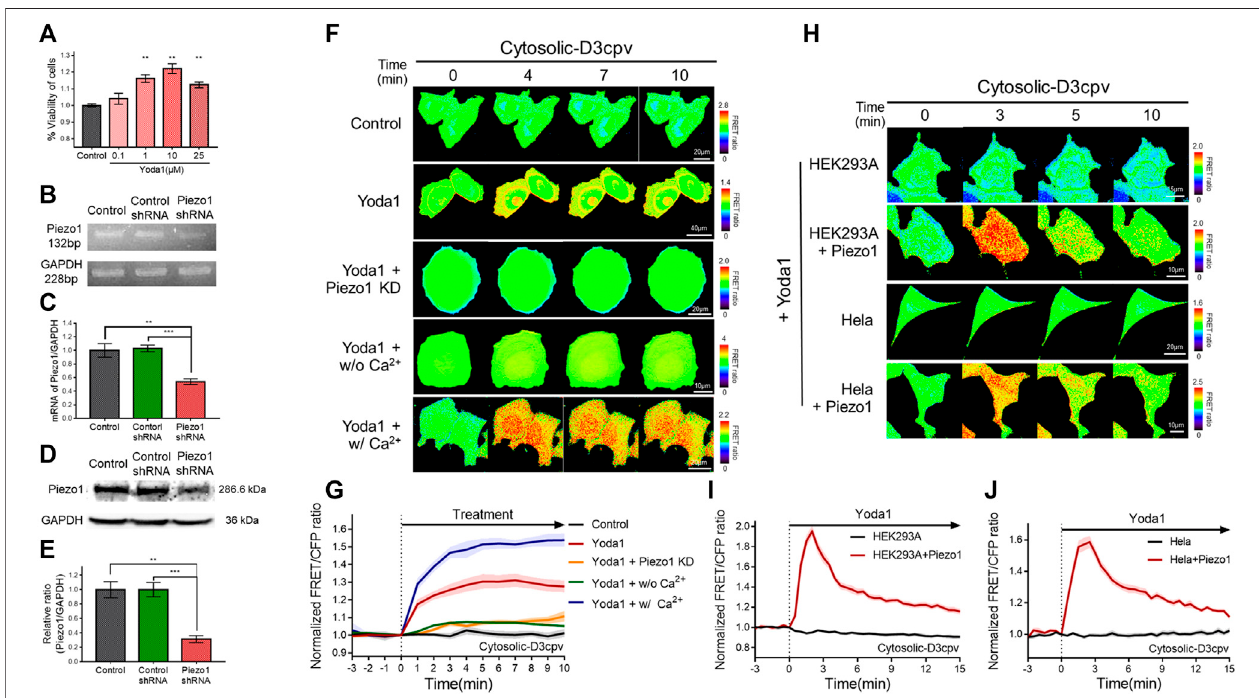
FIGURE 2 | Piezo1-mediated extracellular Ca 2+ in fl ux induced by Yoda1 in various cell lines. (A) Viability of MCF-7 cells exposed to control [0.2% (v/v) DMSO] and Yoda1 (0.1 – 25 μ M) for 24 h, measured using the WST-8 assay. The bar graphs describe mean values of cell viability with error bars indicating the standard error of the mean (S.E.M) ( n = 4, ** p < 0.01, student t -test). (B,D) Piezo1 expression in MCF-7 cells with or without control/Piezo1 shRNA as analysed by (B) RT-PCR and (D) westernblotting.GAPDHwasusedasaninternalcontrol. (C,E) Thebargraphsdescribethecumulativedensitometric analysisof (C) RT-PCRand (E) westernblot bands normalized to the GAPDH. Data are presented as the means ± S.E.M ( n = 4, ** p < 0.01 and *** p < 0.001, student t -test). (F,H) Time-lapse FRET images of the Cytosolic-D3cpvin (F) MCF-7cells, (H) HEK293AandHeLacellsintroducedwithorwithoutexogenousPiezo1.MCF-7cellswereexposedtocontrol[0.2%(v/v)DMSO] and Yoda1 (1 μ M) dissolved in CO 2 -independent culture medium (Yoda1 group), Ca 2+ -free medium (Yoda1 + w/o Ca 2+ group), and Ca 2+ medium (Yoda1 + w/Ca 2+ group), respectively. (F) Yoda1 + Piezo1 KD group and (H) HEK293A and HeLa cells were incubated in CO 2 -independent culture medium. The color scale bars represent the range ofthe FRET/CFP emission ratio determined using the biosensor. Hot and cold colors indicate high and lowCa 2+ concentration, respectively. (G,I,J) ThetimecoursesrepresenttheaverageofthenormalizedFRET/CFPemissionratiochangesofcytosolic-D3cpvin (G) MCF-7, (I) HEK293A,and (J) HeLacells.Thelines are mean values of normalized emission ratios, with diluted colors indicating the S.E.M ( n = 7).